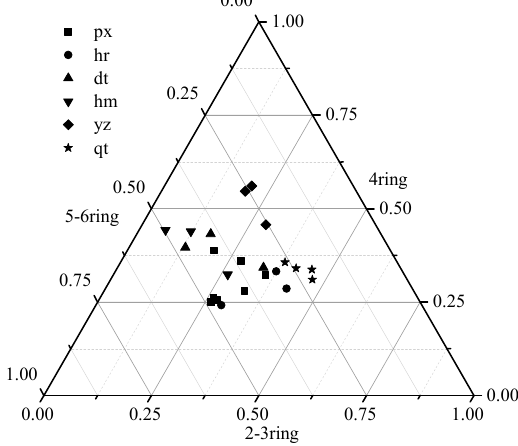
Figure 3. Triangle graph of percentage density for 15 PAHs in the sampling sites.